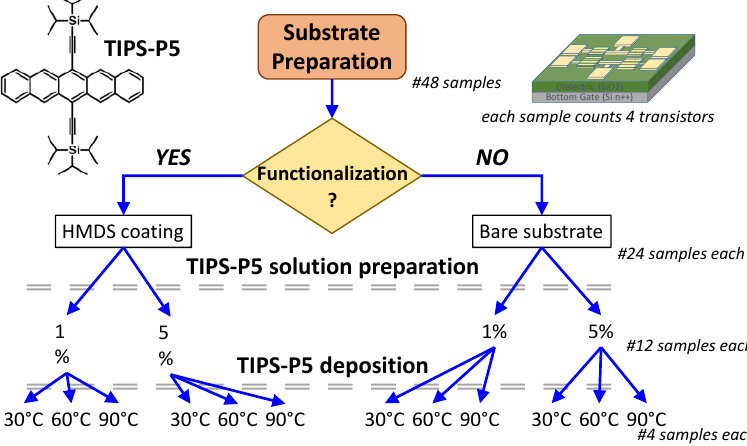
Figure 2. Flowchart of the devices’ fabrication procedure .